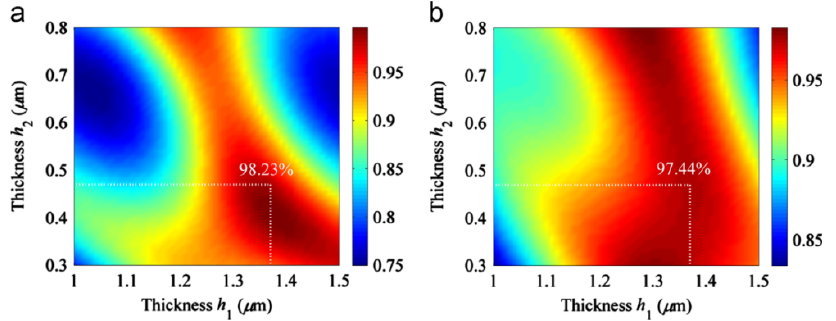
Figure 34. Diffraction efficiency in the –1st order versus grating depths of the two ‐ layer grating: ( a ) TE polarization and ( b ) TM polarization. ( a ) TE polarization and ( b ) TM